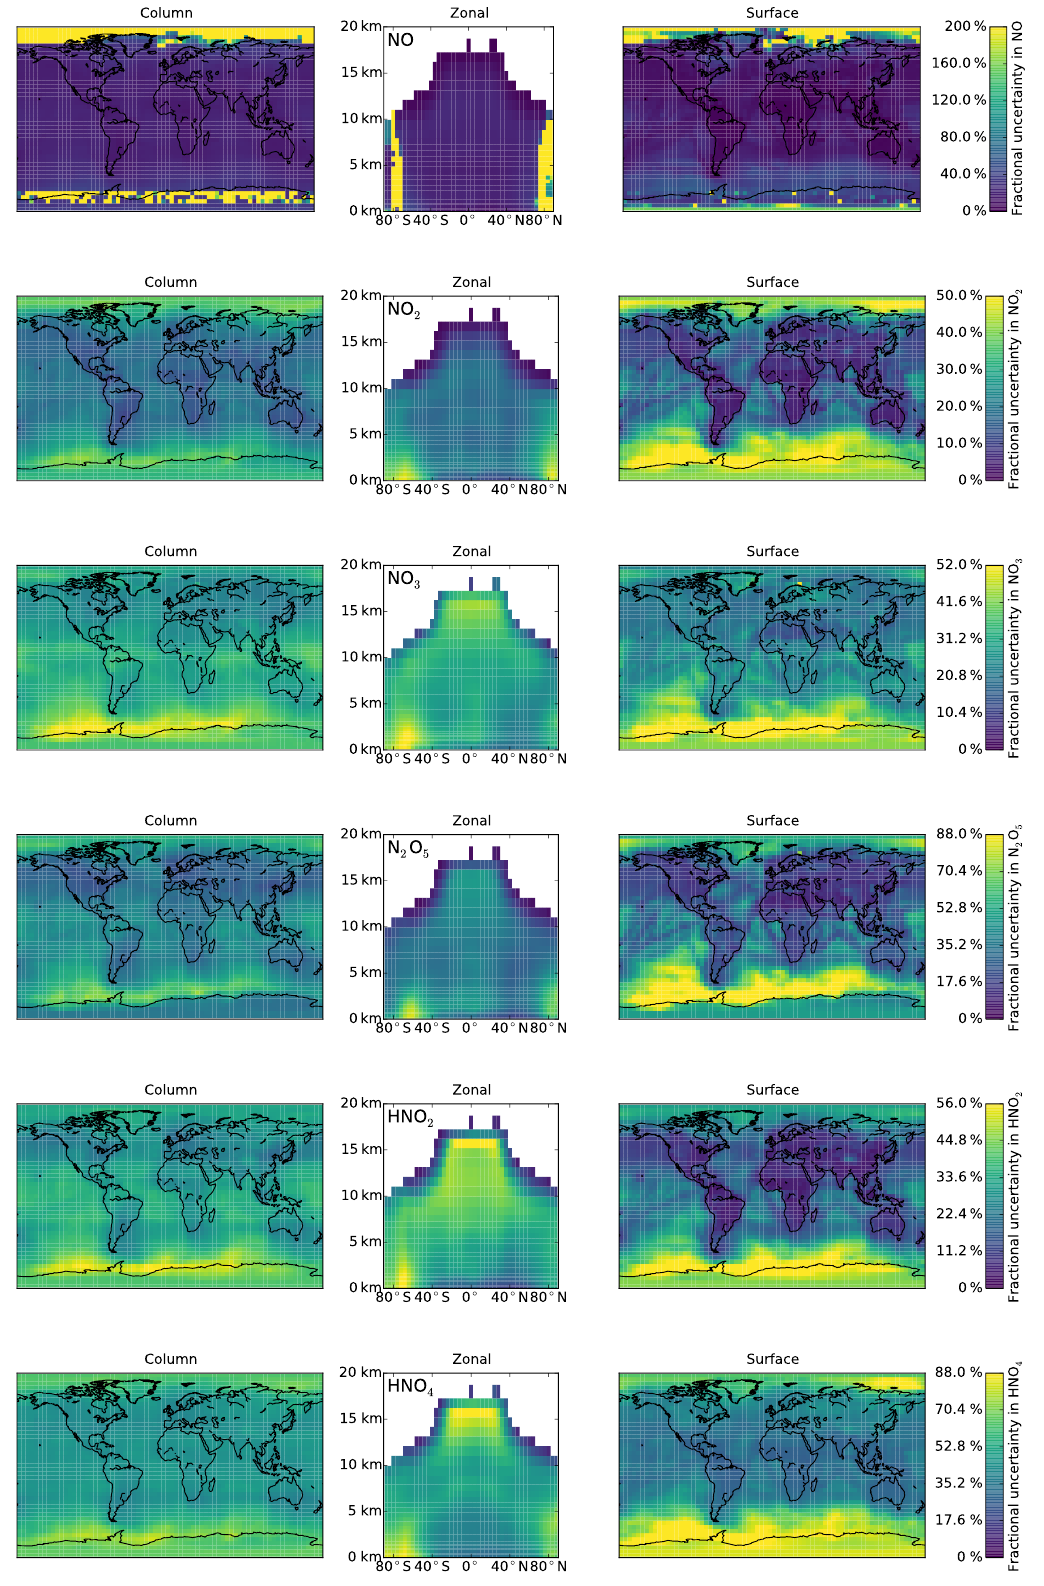
Figure 8. NO x : total 1 σ uncertainty in the concentrations of NO, NO 2 , NO 3 , N 2 O 5 , HNO 2 and HNO 4 from the addition in quadrature of the individual reaction uncertainties. “Column” covers the tropospheric